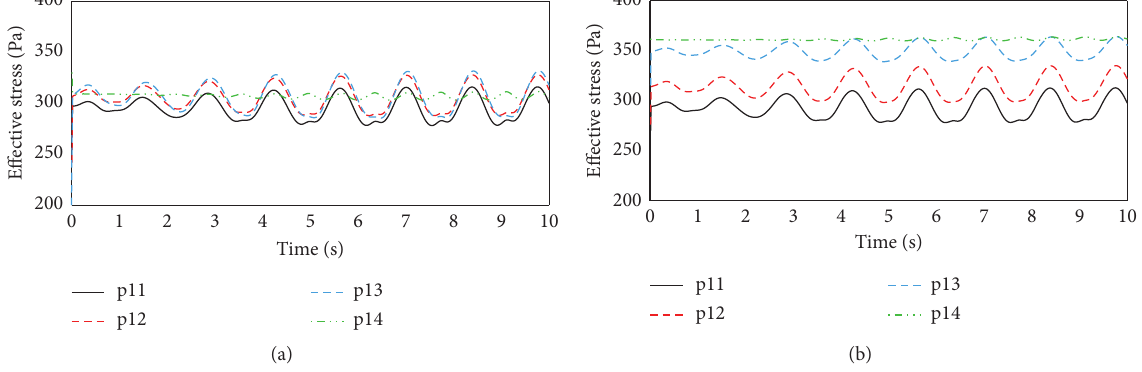
Figure 15: Comparison of effective stress in horizontal direction of different baffles: (a) tank with T-type baffle; (b) tank with double-side curved